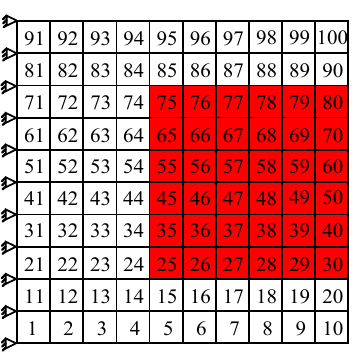
Figure 12. The new damping optimization scheme for the fourth order (bigger coating area). Table 8. Comparison of modal loss factors for the new, original scheme and the full coating structure. Orders